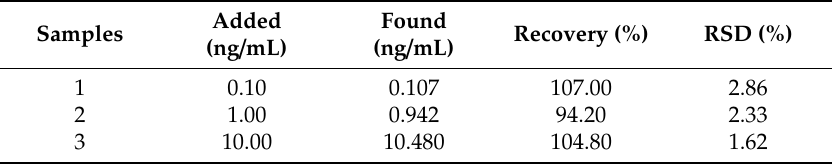
Table 2. Detection of CEA in human serum